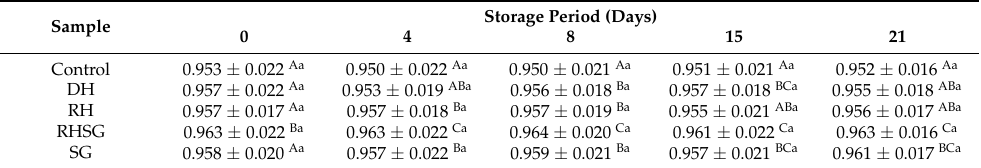
Table 4. Effects of additives and storage period (days) on the aw-value of grilled patties. Values are least square means ± standard deviation.